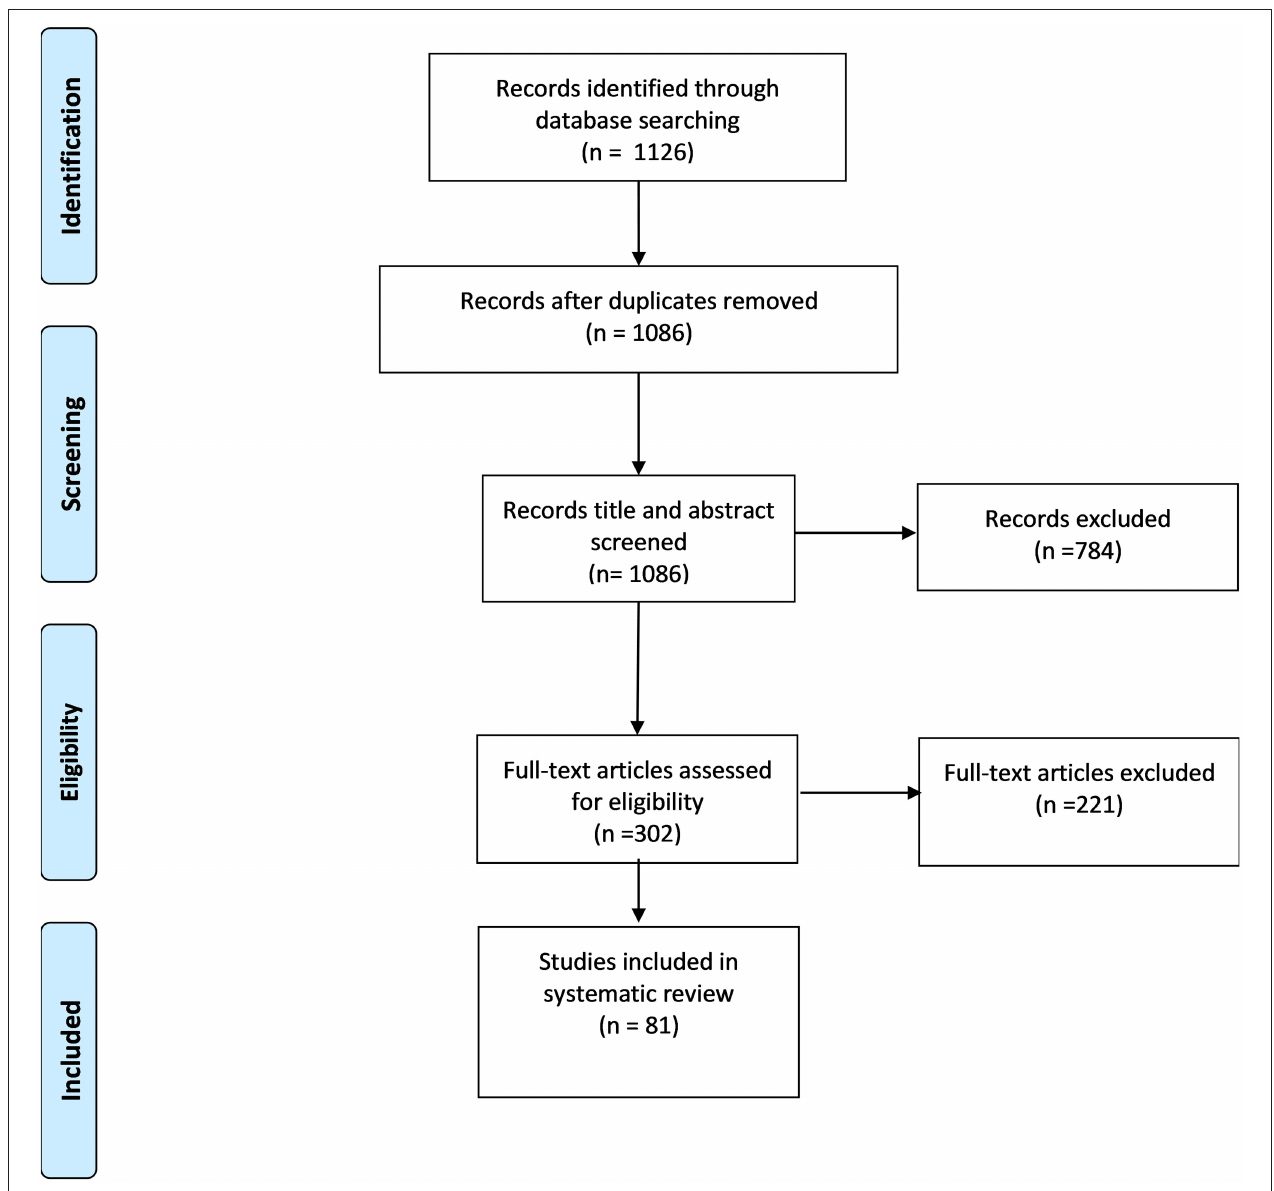
FIGURE 1 | PRISMA flow diagram of the systematic search